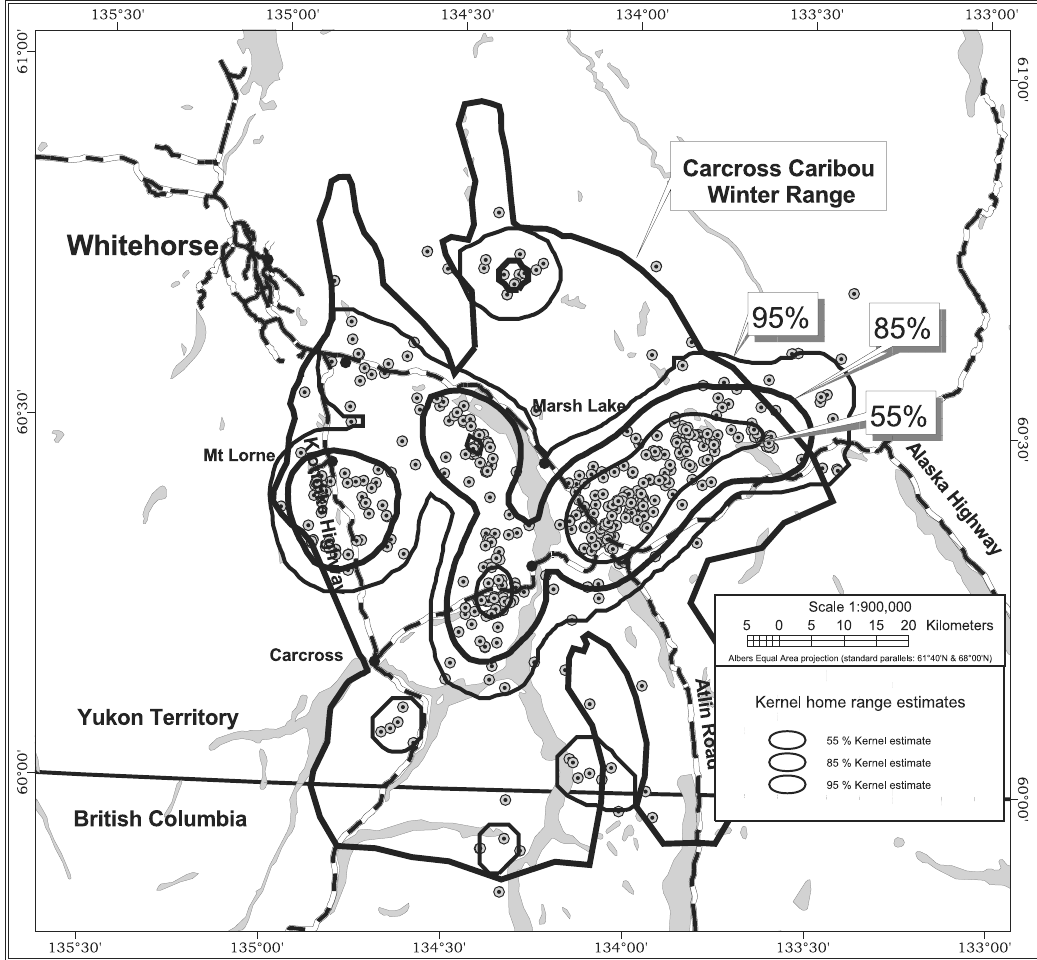
Fig. 3. Kernel home range estimate for 41 radio collared caribou in the Carcross caribou winter